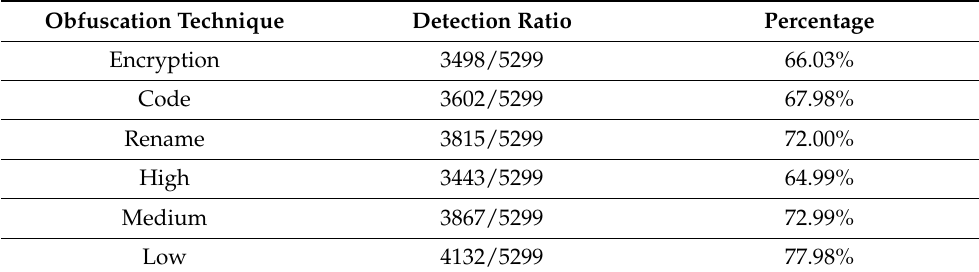
Table 7. Detection Ratio based on Obfuscation Strategies.